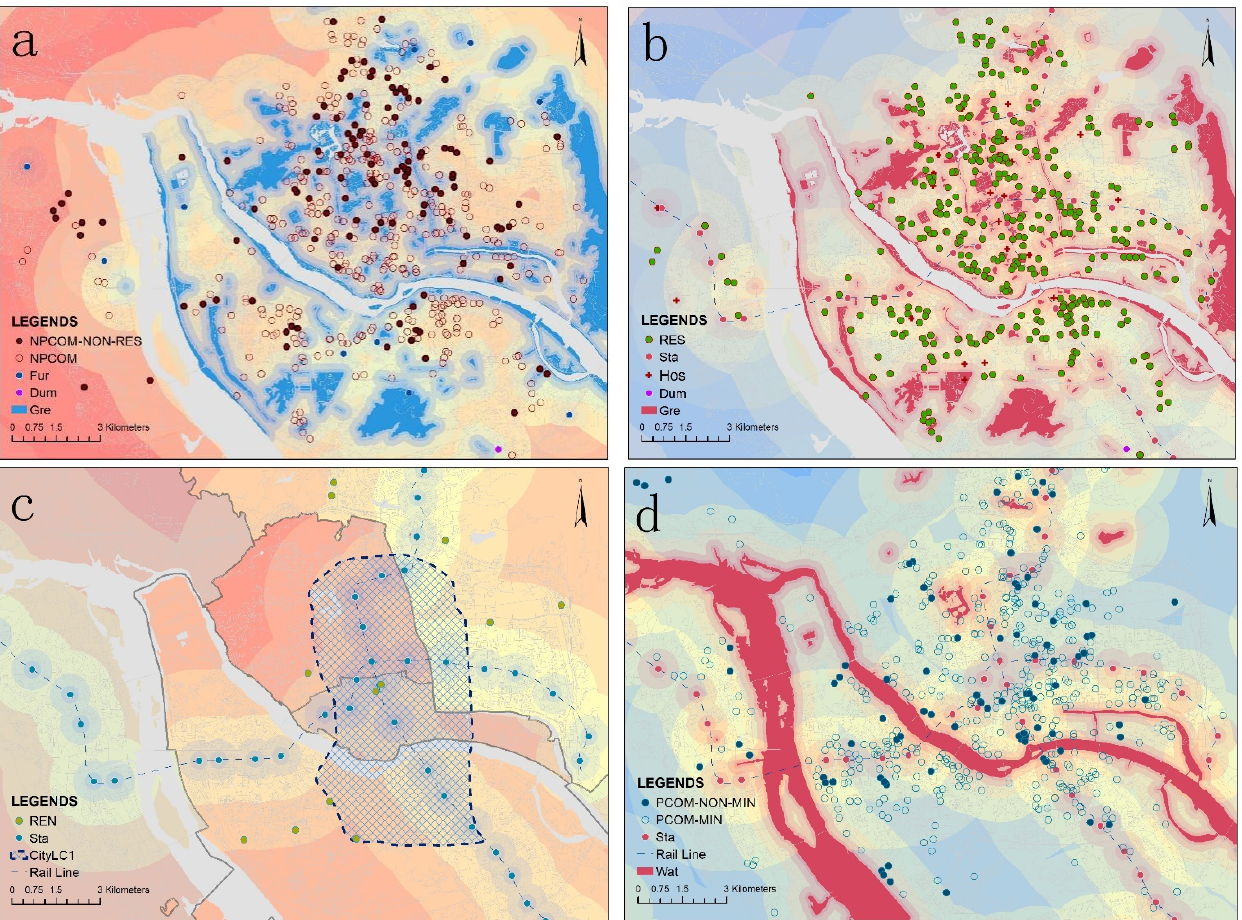
Figure 7. Relationship between housing prices and land space. ( a ) NPCOM, ( b ) RES, ( c ) REN, ( d ) PCOM.